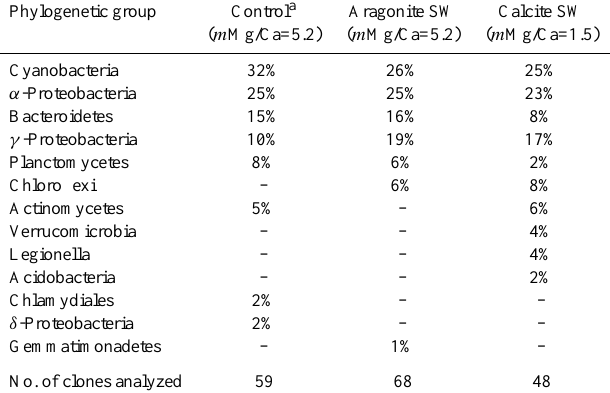
Phylogenetic group Control a Aragonite